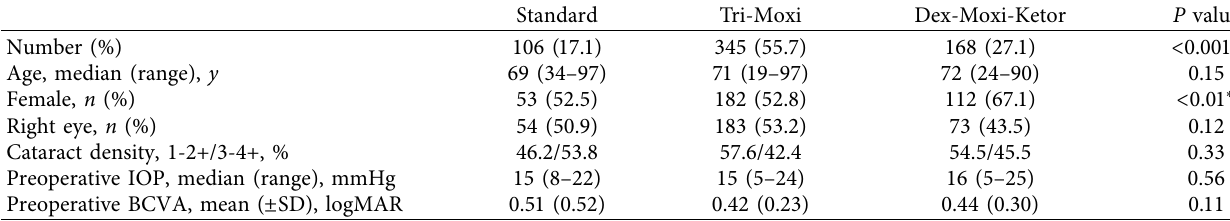
Table 1: Baseline characteristics of the study participants.